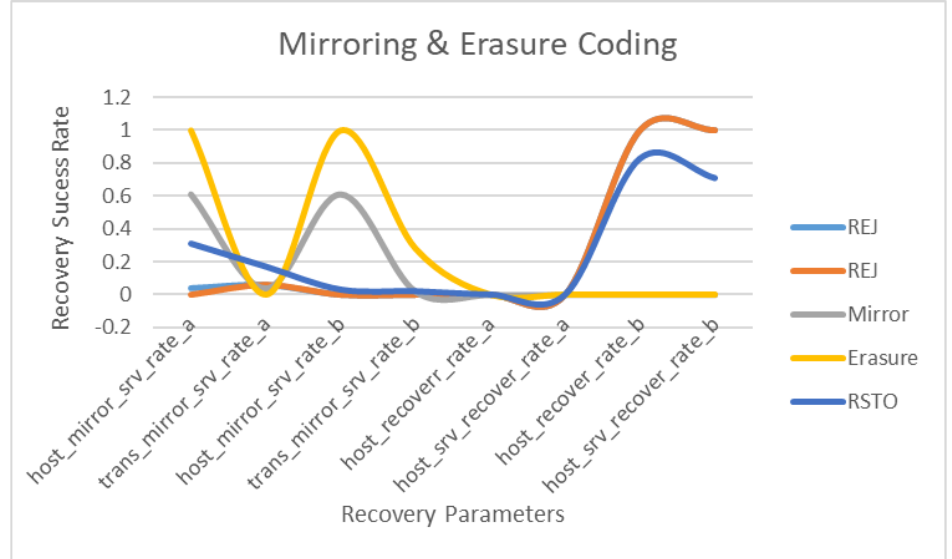
Figure 4. Mirroring and Erasure Coding Graph on RAID.